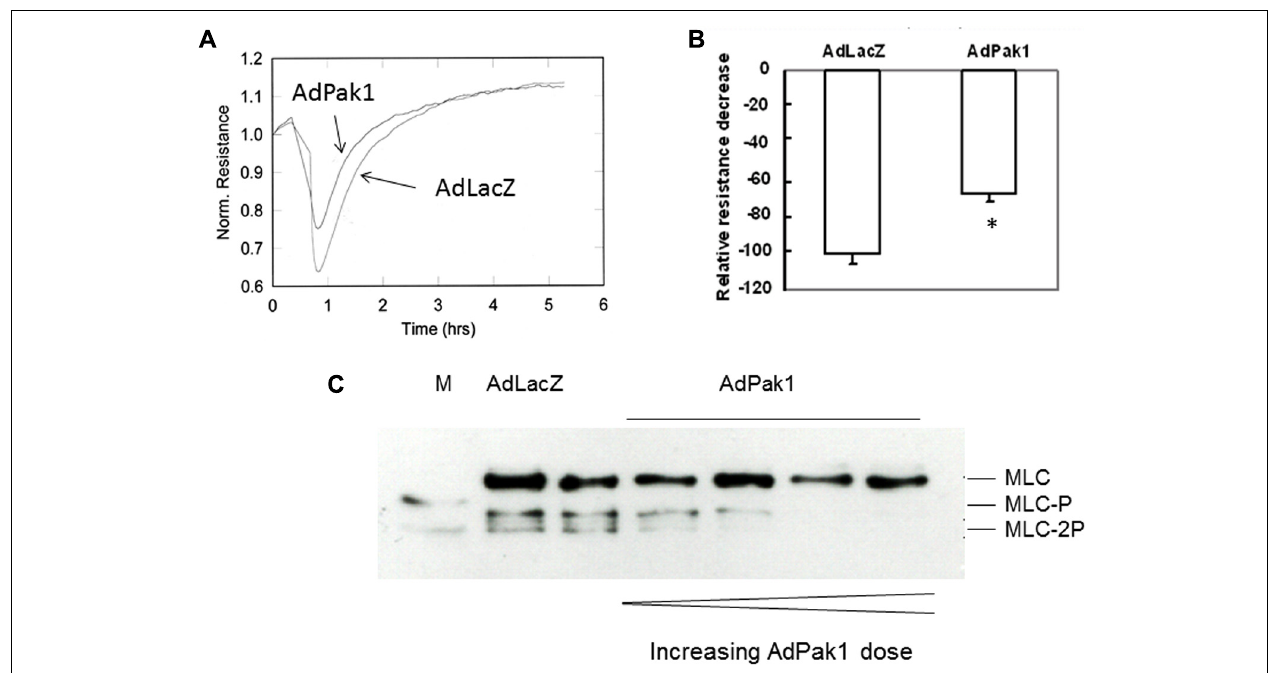
resistance drop induced by thrombin is rescued by Pak1; (C) Pak1 reduces phosphorylation of myosin regulatory light chain (MLC 20 ) at both threonine 18 and serine19 through activation of PP2A. M, phosphorylated MLC 20 as marker; Ctrl, control; AdPak1, recombinant adenovirus expressing constitutively active